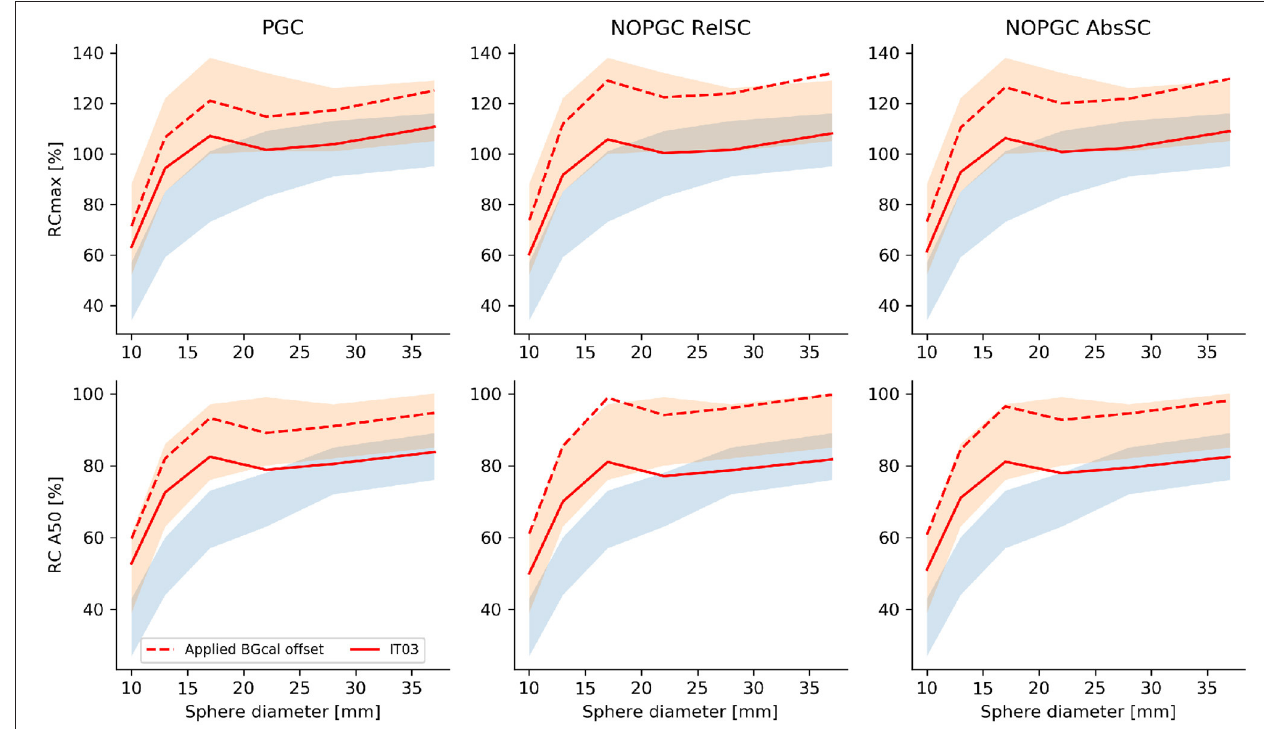
FIGURE 4 | RC max and RC A 50 obtained as a function of the sphere size for the optimal reconstruction (3 iterations and 21 subsets) and for the different scatter/PGC tested corrections (red full lines). Additionally we presented corrected RCs obtained by compensating for the low BGcal measured in the PET reconstructions to match a BGcal offset of 1 (red dashed lines). The EANM/EARL reference range of values is within the blue shaded area, the RC range of values proposed by Kaelep et al. [34] is within the red shaded area.